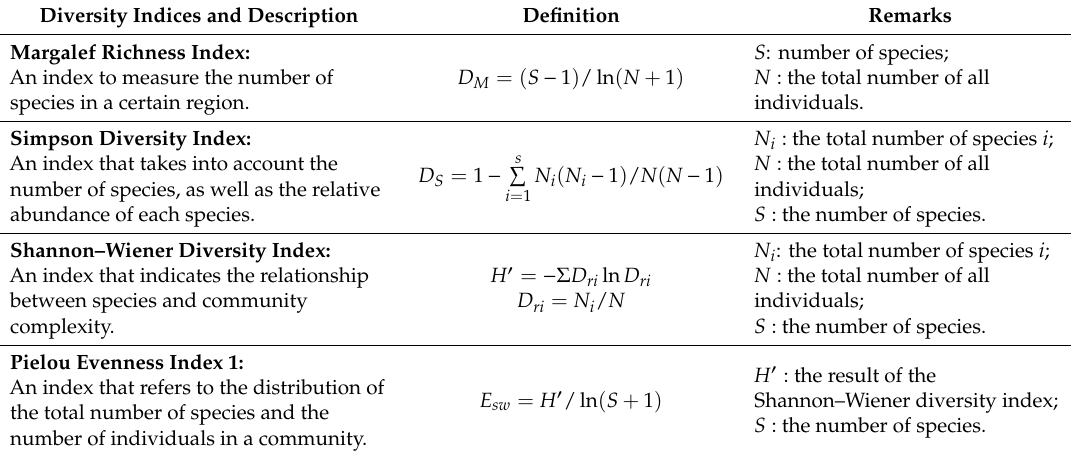
Table 1. The diversity indices used in this